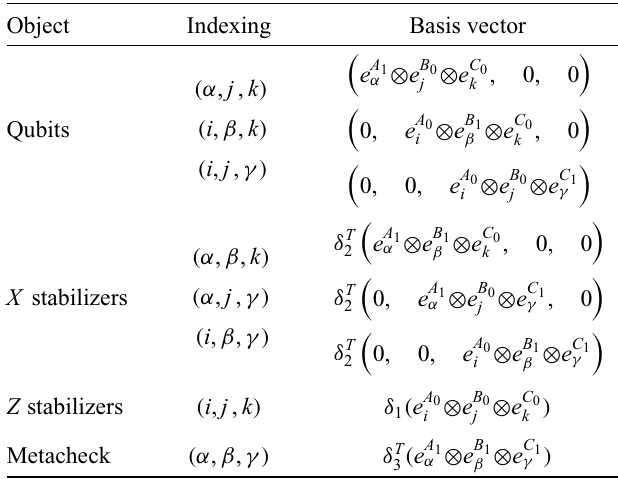
TABLE IV. Notation and correspondences between objects of the chain complex ( C (cid:11)(cid:11)(cid:11) ).